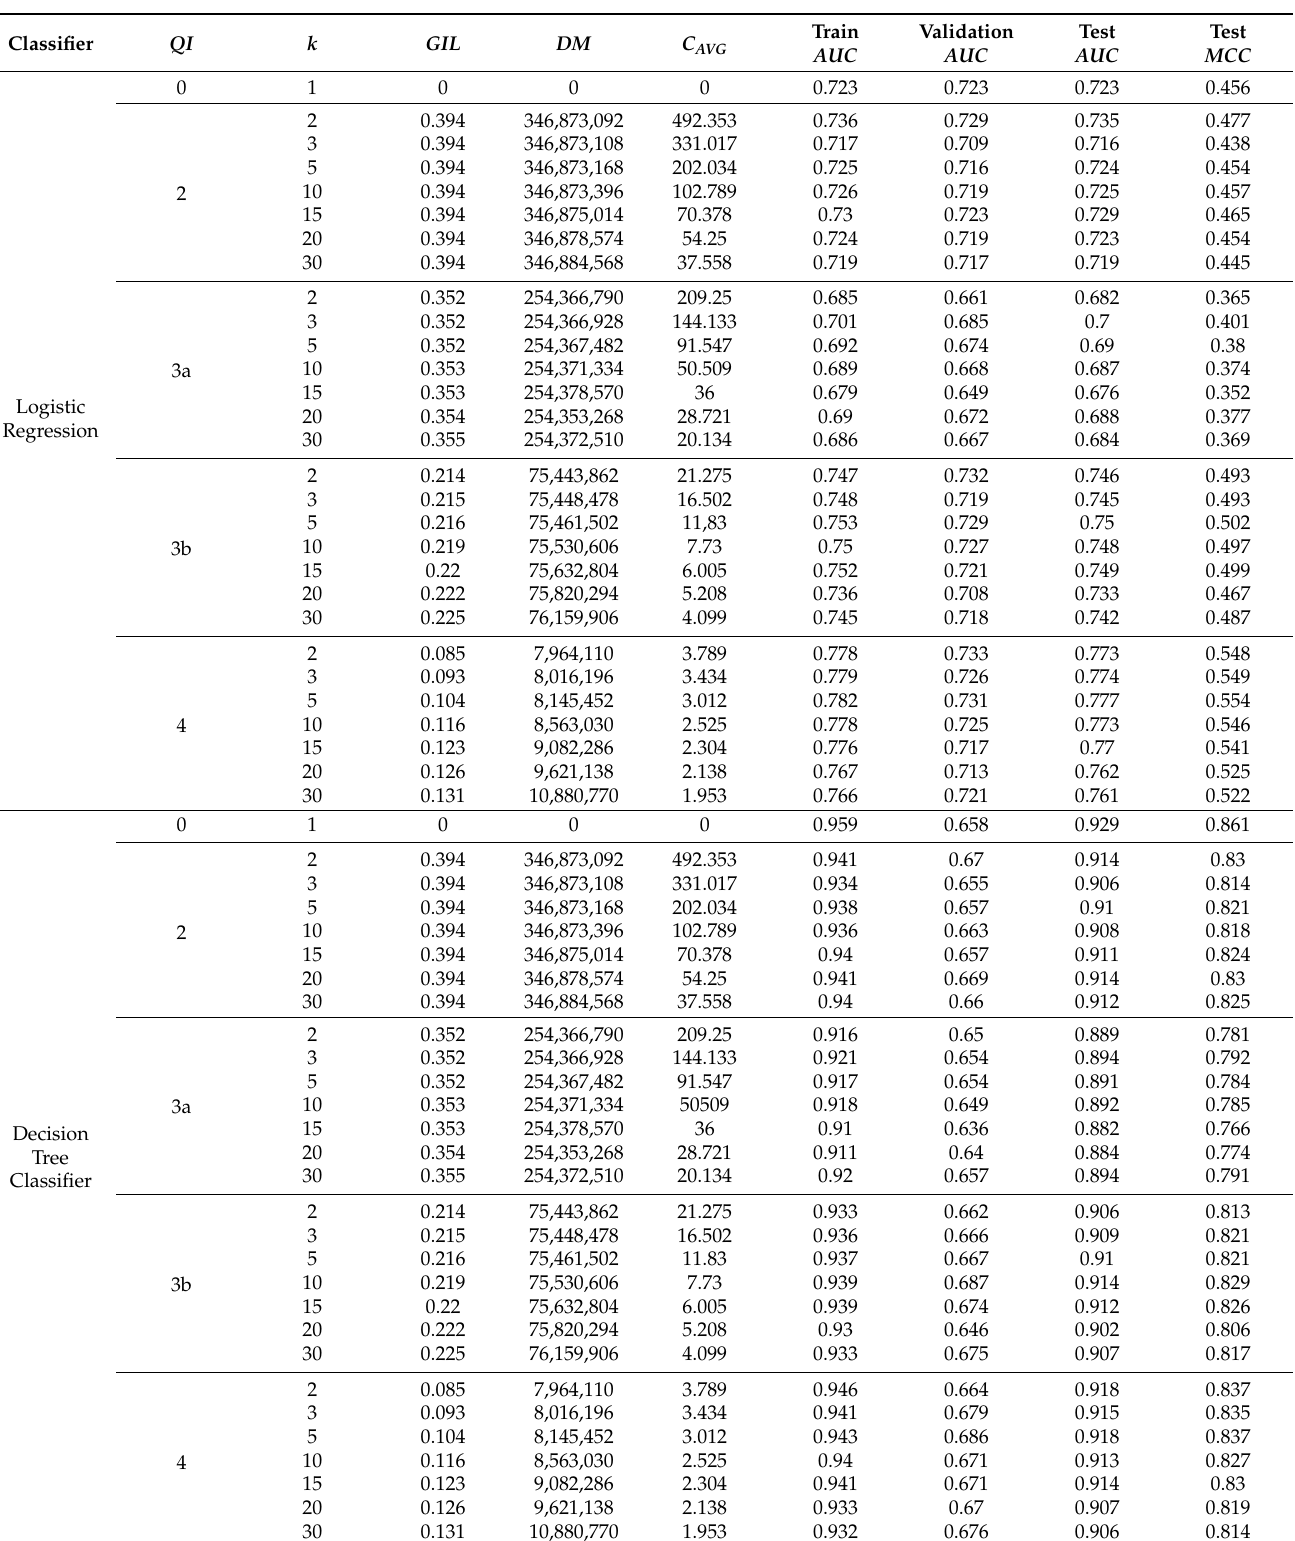
Table A2. The results of the application of five machine learning models to the dataset for various values of the parameters QI , k . The performance of the models was evaluated with the area under the curve (AUC) and Matthews correlation coefficient (MCC) metrics. The generalized information loss (GIL), discernibility metric (DM) and average class size (C AVG ) captured the information loss occurring due to the anonymization